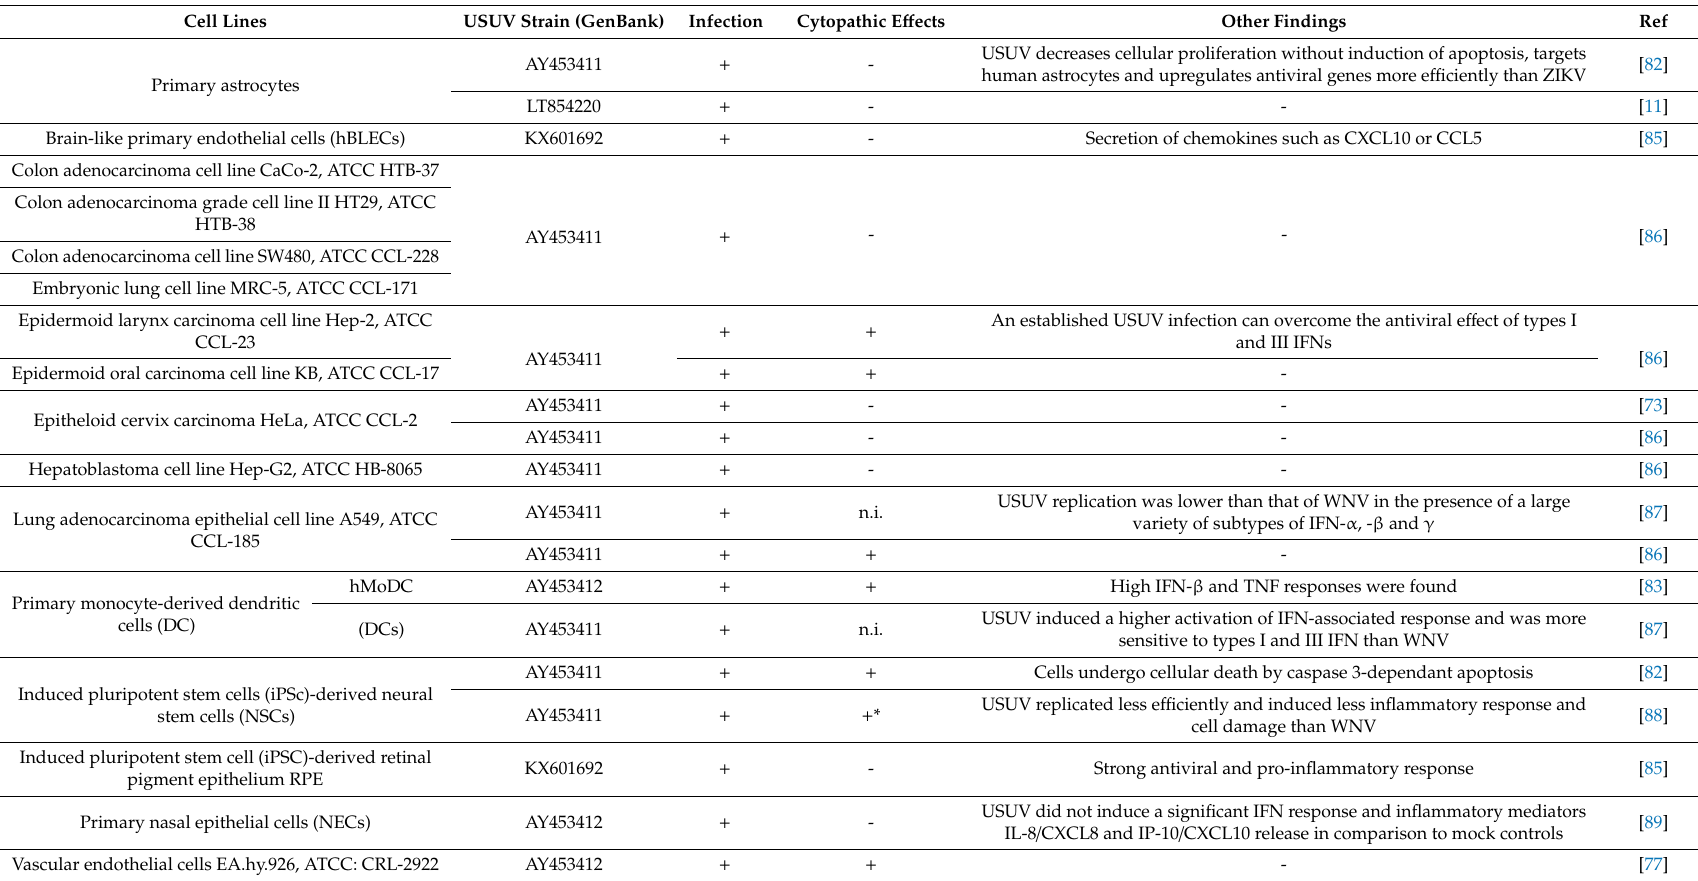
Table 2. List of human cell lines used for the characterization of Usutu virus